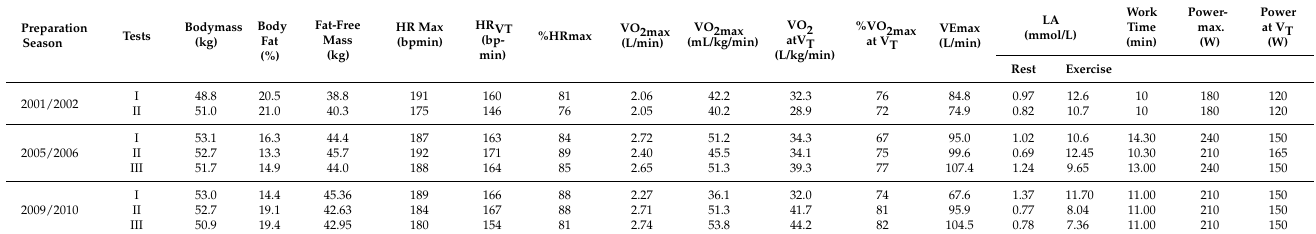
Table 1. Morpho-functional values achieved by the study participant during endurance tests in Paralympic preparation seasons: 2001/2002, 2005/2006,